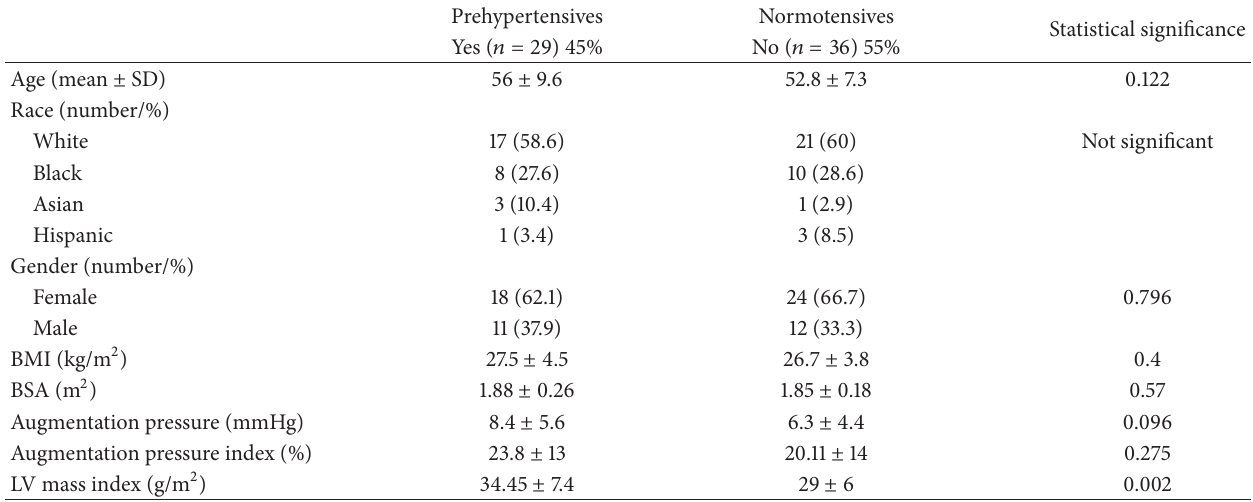
Table 1: Patient’s characteristics, left ventricular mass index, and blood pressure categories.